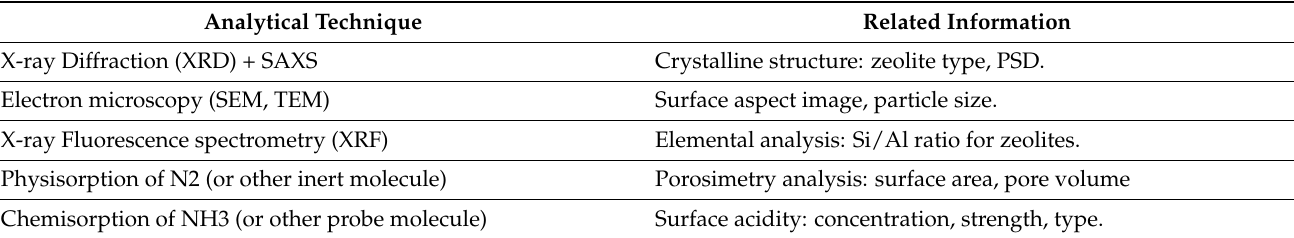
Table 6. Principal analytical techniques used for characterization of fresh and deactivated catalysts. Analytical Technique Related Information X-ray Diffraction (XRD) + SAXS Crystalline structure: zeolite type, PSD. Electron microscopy (SEM, TEM) Surface aspect image, particle size. X-ray Fluorescence spectrometry (XRF) Elemental analysis: Si/Al ratio for zeolites. Physisorption of N2 (or other inert molecule) Porosimetry analysis: surface area, pore volume Chemisorption of NH3 (or other probe molecule) Surface acidity: concentration, strength,